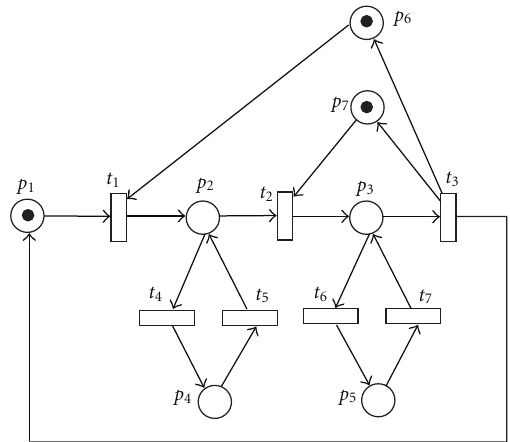
Figure 7: The Petri Net model of a flexible manufacturing